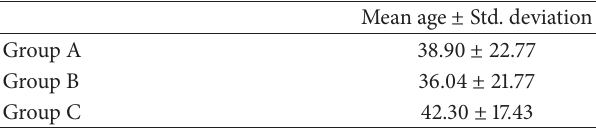
Table 2: The average age of groups A, B, and C.